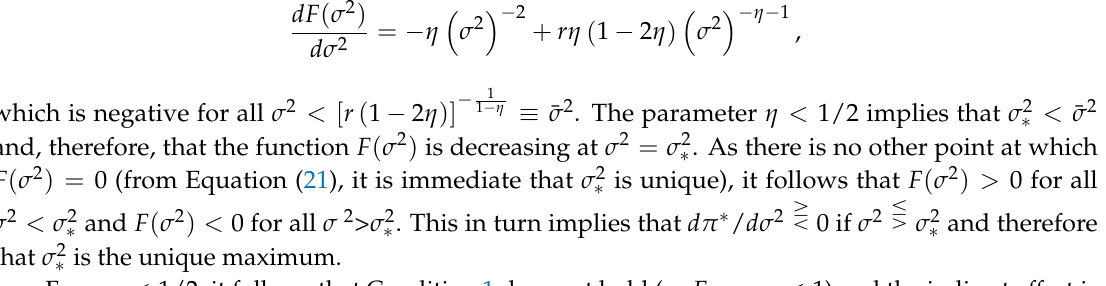
Table 94: wasysym Inequalities